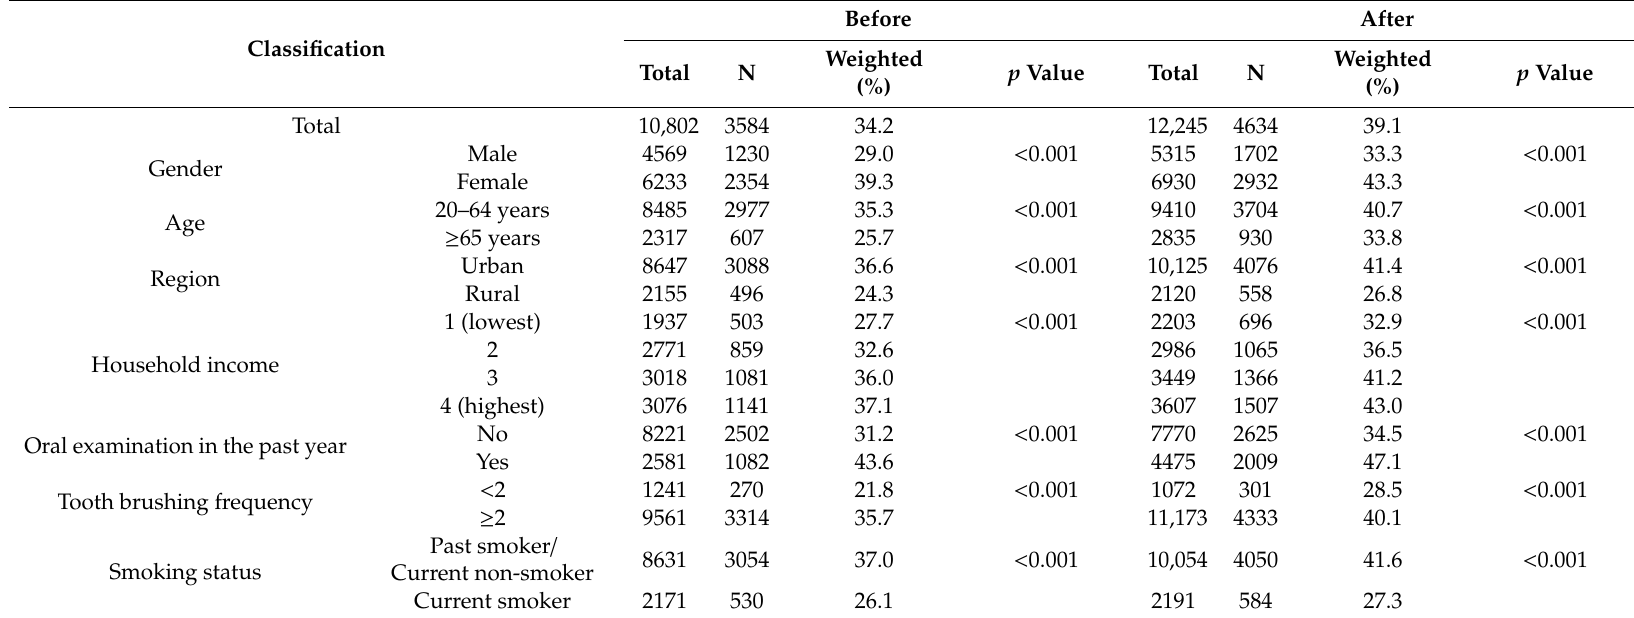
Table 2. Changes in the prevalence of healthy periodontal tissues according to health insurance coverage for dental scaling.